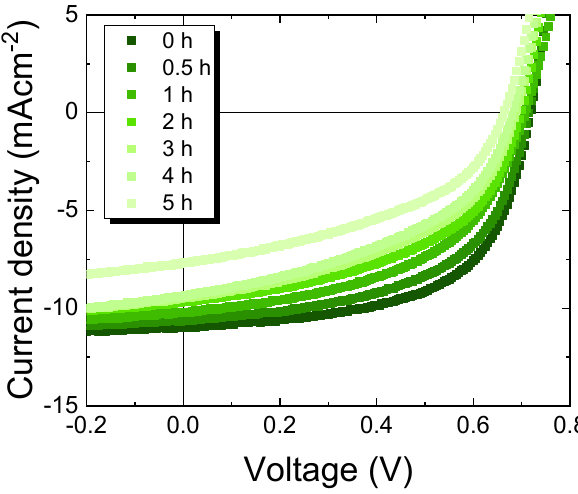
Figure 9. J–V characteristics of 40 wt% PTB7:PC 71 BM inverted OPV under 100 mWcm − 2 AM1.5G irradiation at different stages of photo-induced degradation.